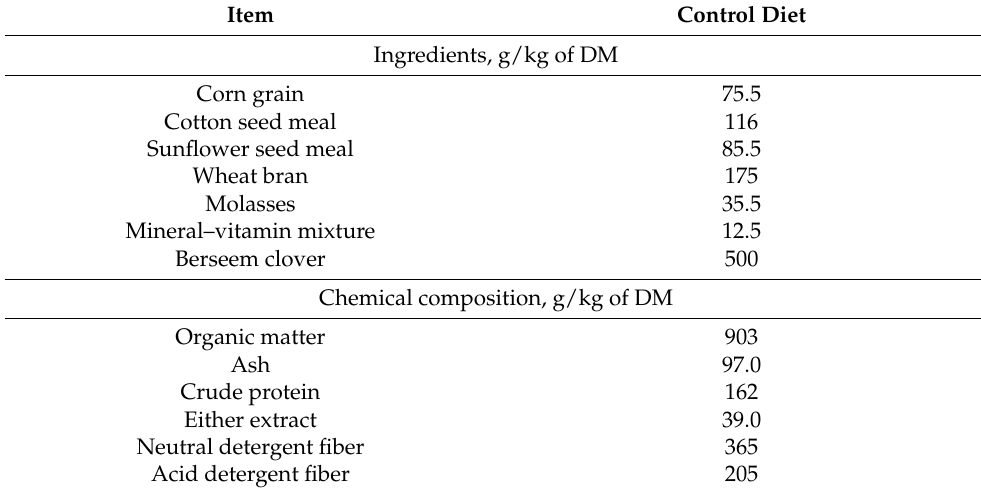
Table 1. Ingredients and chemical composition of the control diet.